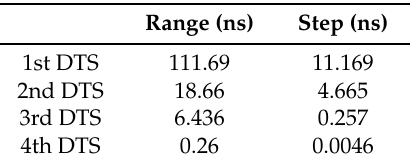
Figure 9. The testing platform of the DCO chip.